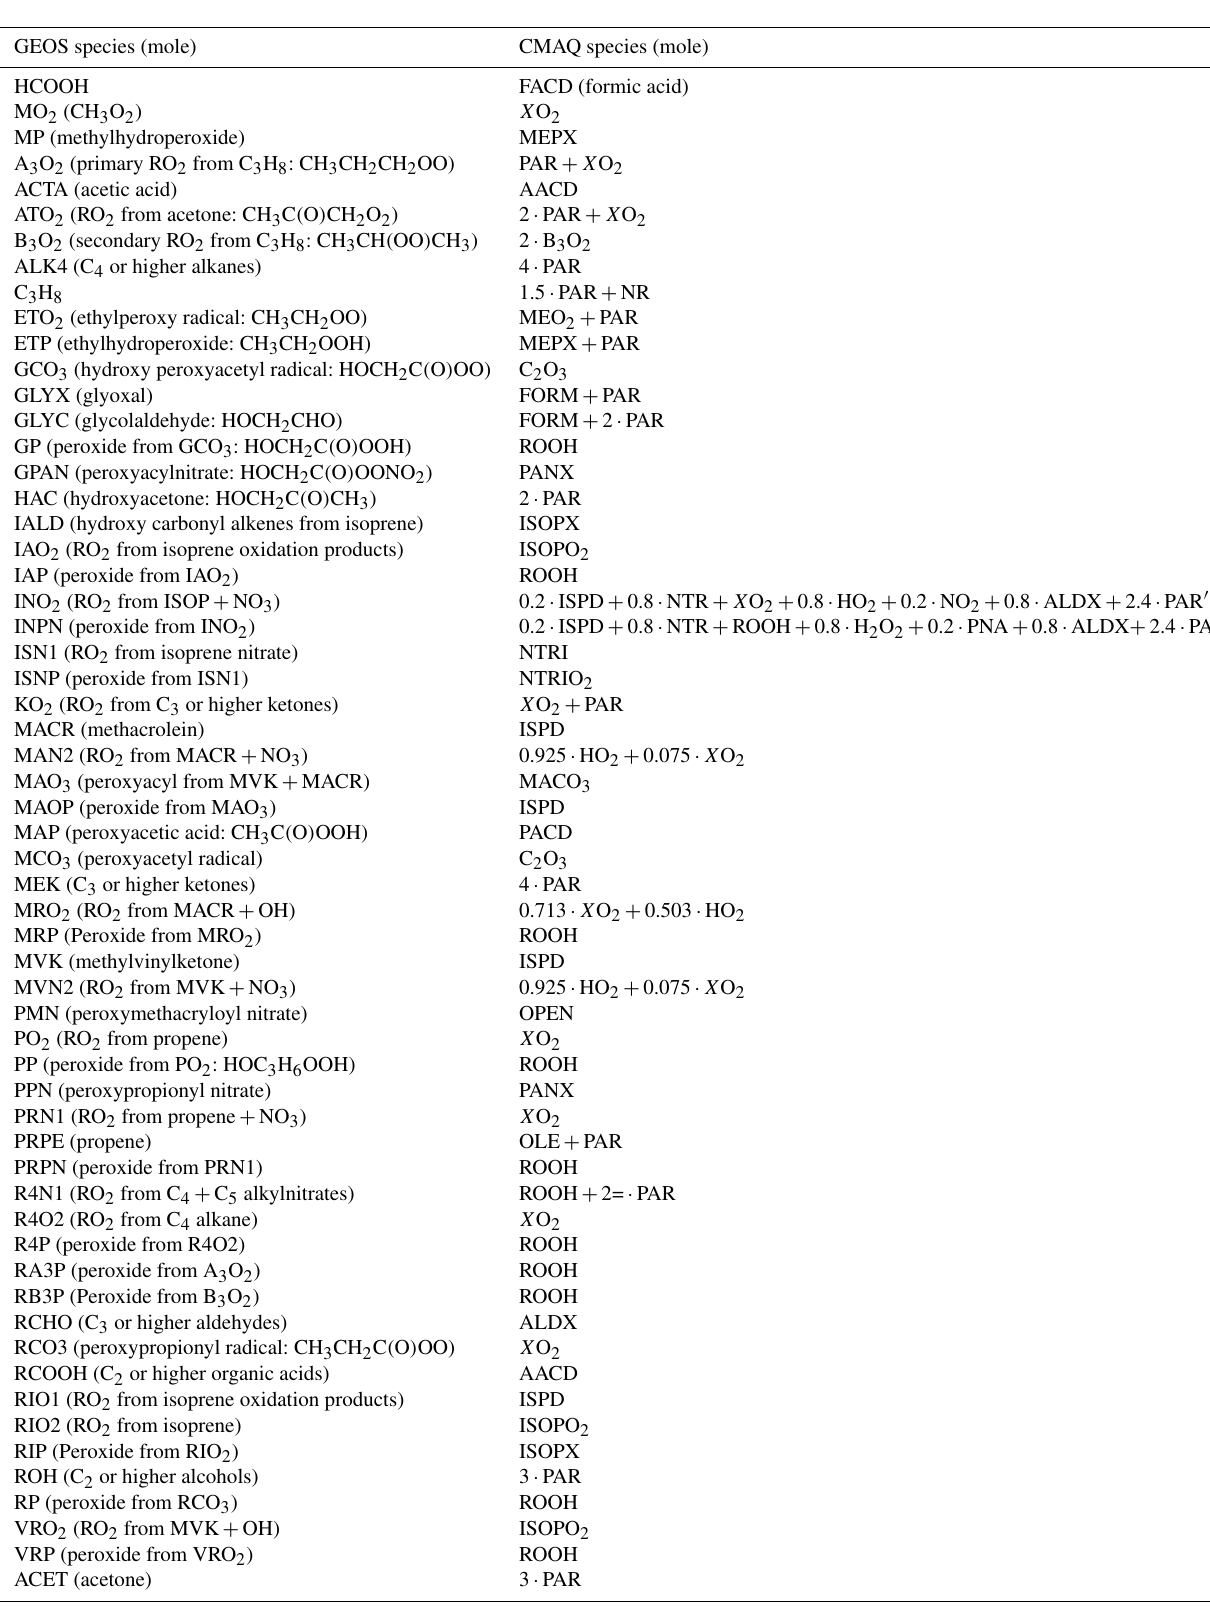
Table 2. VOC (volatile organic compound) species mapping table from GEOS to CMAQ CB05tucl. GEOS species (mole) CMAQ species